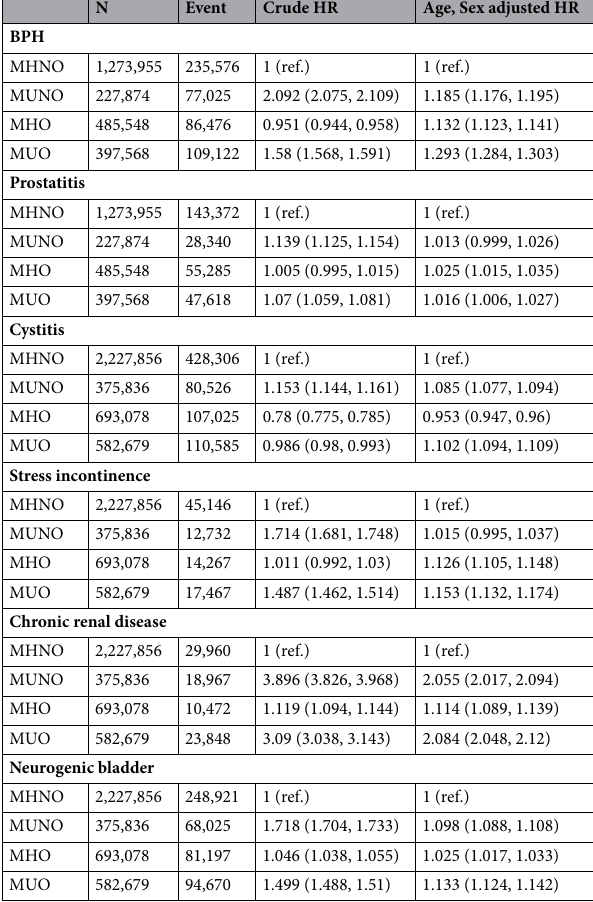
Table 2. Diagnosis related to urological disorders according to BMI and metabolic health status. Data are expressed as HRs (95% confidence interval). BPH benign prostate hyperplasia; MHNO metabolically healthy non-obese; MHO metabolically healthy obese; MUNO metabolically unhealthy nonobese; MUO metabolically unhealthy